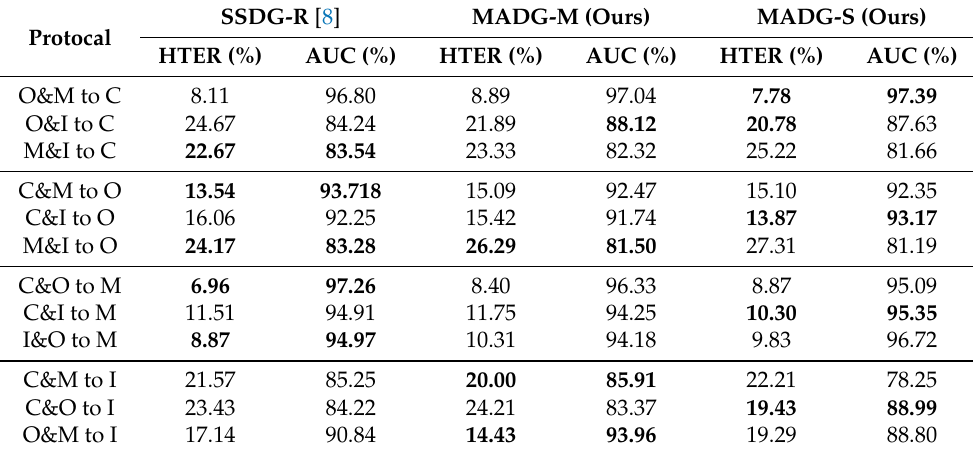
Table 5. Experiments on limited source domains involving twelve task protocols. The header is the baseline method and ours; the bold represents the optimal result.